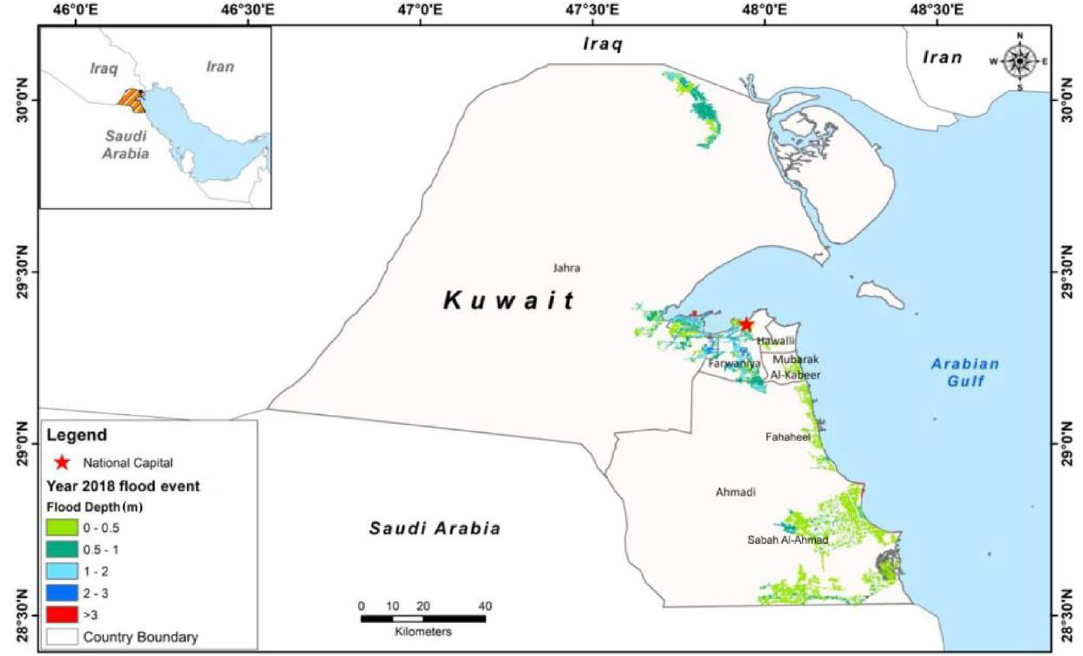
Fig. 3 Flood hazard map for Kuwait based on a major flood event, 4–14 November 2018. Source Kuwait Institute for Scientific Research